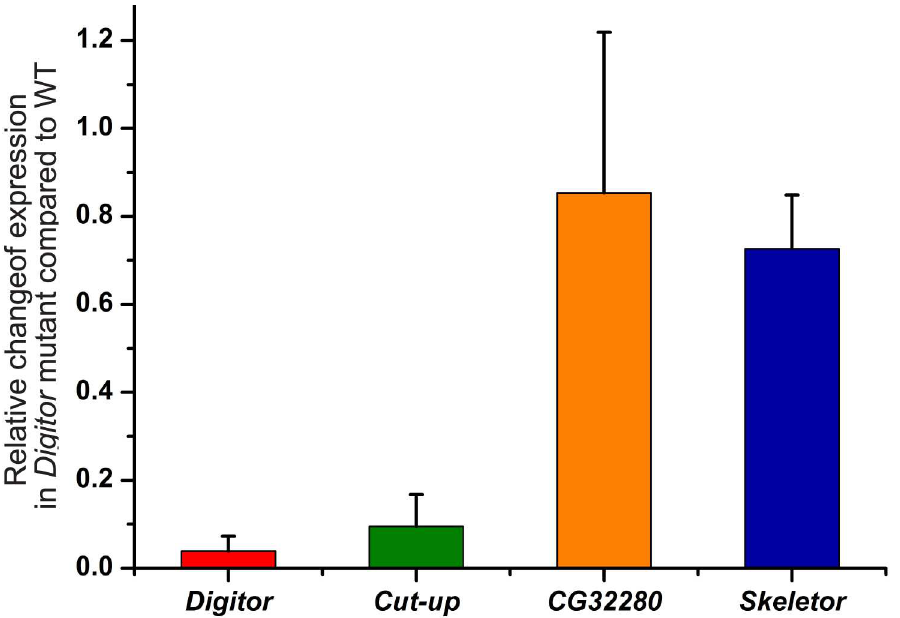
Fig 7. Transcript levels in the Digitor null mutant relative to wild type. Relativetranscript levels of Digitor/ dASCIZ , Cut up , CG32280 , and Skeletor in Digitor mutant ( EP(3)3709/EP(3)3709 ) third instar larvae as comparedto wild type. The transcript levels of all four geneswere determined by qRT-PCR and fold change was calculatedaccordingto the 2- ΔΔ Ctmethod. Each determination was performed in triplicate and the averageis shown with